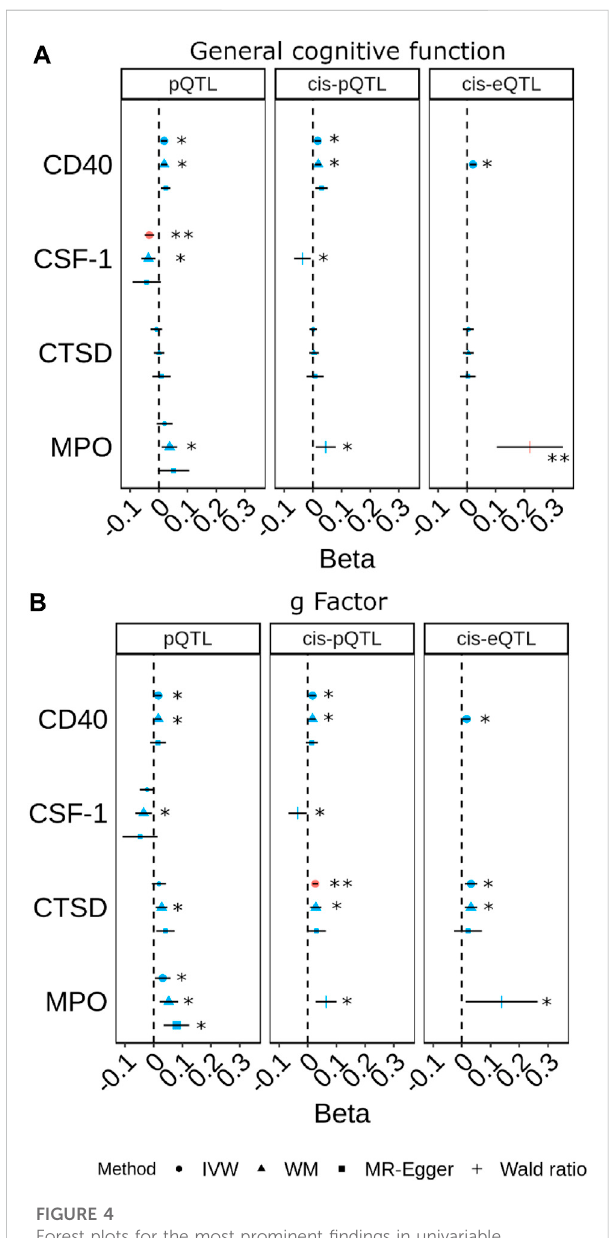
FIGURE 4 Forest plots for the most prominent fi ndings in univariable Mendelian randomisation (MR) for the associations of genetically predicted plasma protein concentrations with cognitive traits ( (A) general cognitive function. (B) g Factor). Each panel indicates the estimatesfromMRanalysis basedon threesets ofselectioncriteriafor genetic instruments. The shape in red and the double asterisk symbol (**) indicate an association with a p -value < 0.05/180. The symbol in blue and larger in size and the asterisk symbol (*) indicate an association with a p -value < 0.05. (Inverse-variance weighted (IVW); weighted median